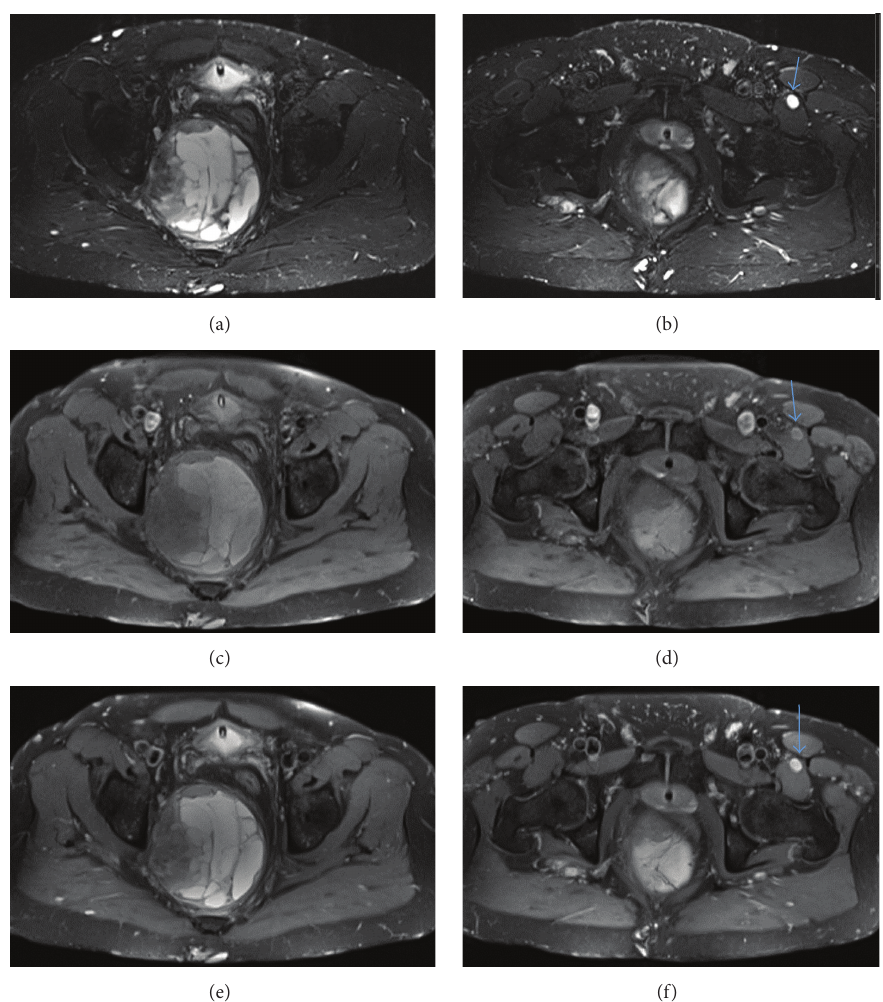
Figure 1: (a) Axial STIR shows pelvic mass. (b) Axial STIR shows pelvic left vastus medialis/intermedius muscle fibroma. (c) Axial T1 FS pelvic mass. (d) Axial T1 FS left vastus medialis/intermedius muscle fibroma. (e) Axial PD FS shows pelvic mass. (f) Axial PD FS shows left vastus medialis/intermedius muscle